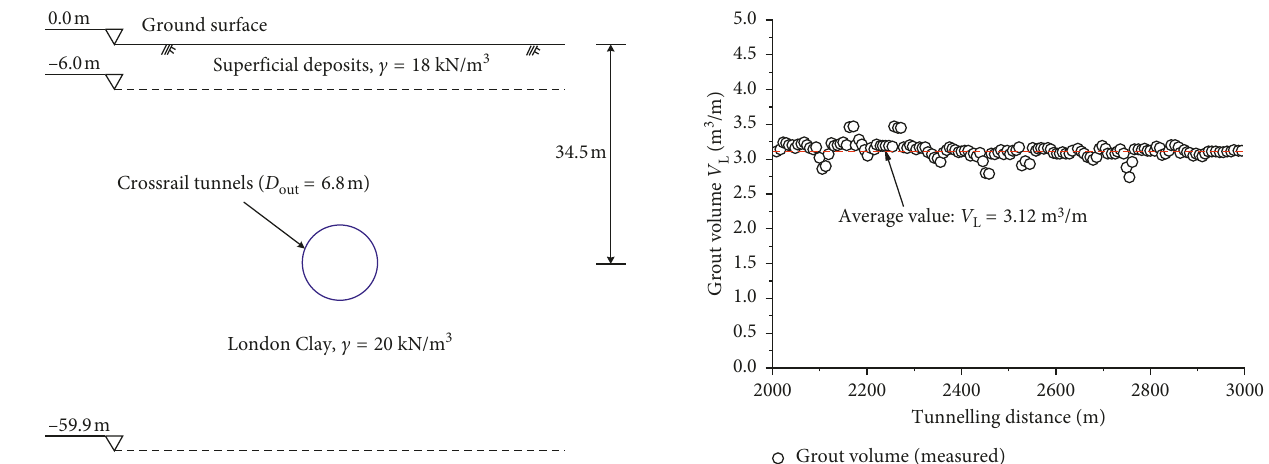
Figure 3: Geotechnical conditions and cross-sectional view of the tunnel layout in the case history. c , unit weight (created based on [23]).